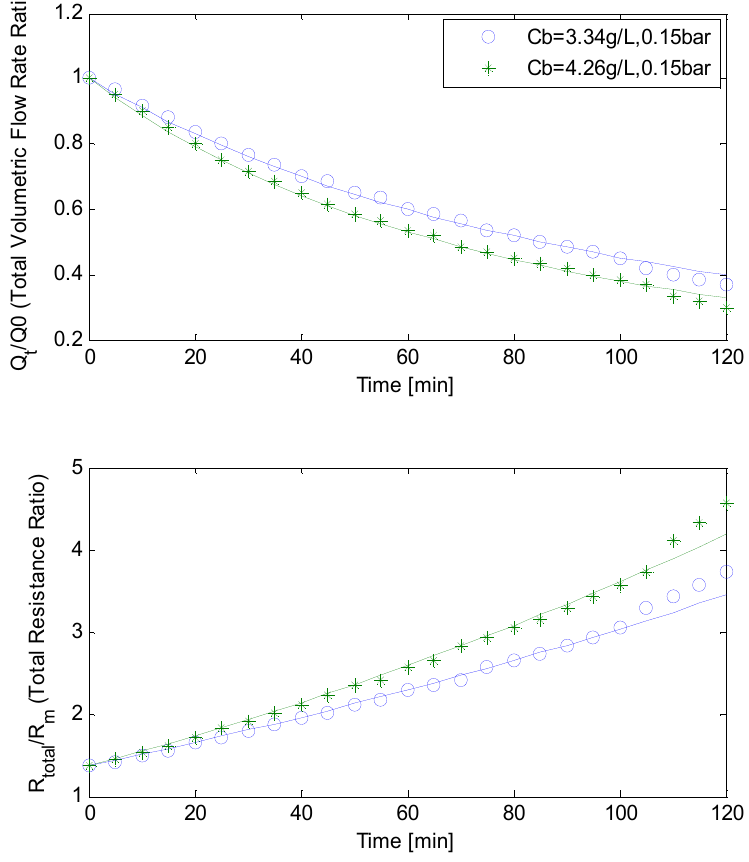
Figure 5. Flux decline and total resistance for flux step at trans-membrane pressure (TMP) 15 kPa for